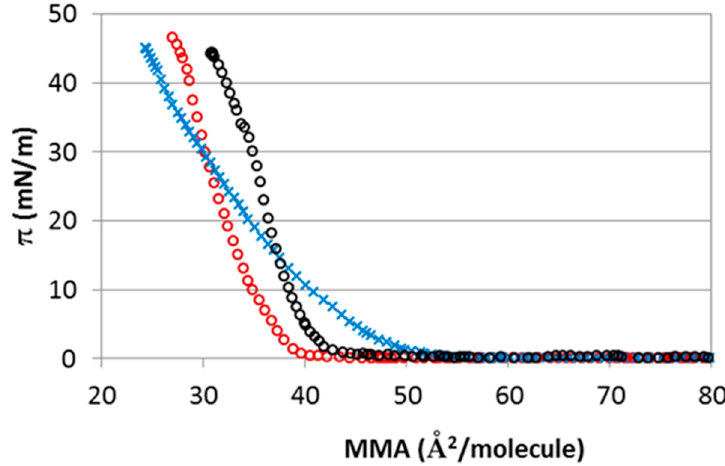
Figure 8. Isotherm of surface pressure ( π ) vs. area per molecule (MMA) of CHOL monolayers in a 5 mM subphase of MgCl 2 (blue crosses), CaCl 2 (red open circles) and in a 15 mM subphase of NaCl (black open circles) (standard deviation <2%).